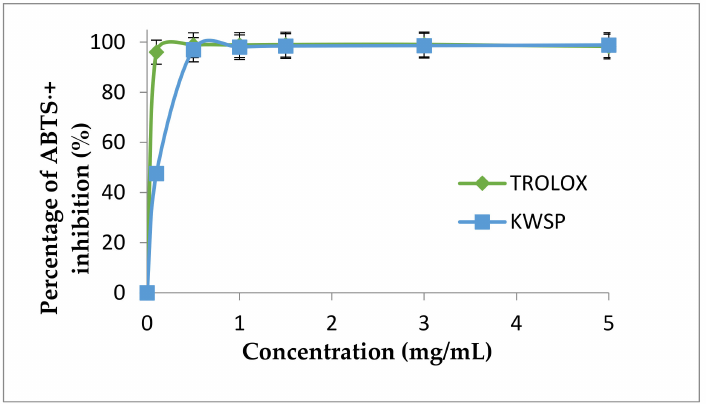
Figure 10. ABTS · + radical scavenging activity according to the concentration of polysaccharide. Each point represents the mean of three independent experiments (SD < 10% of the mean).